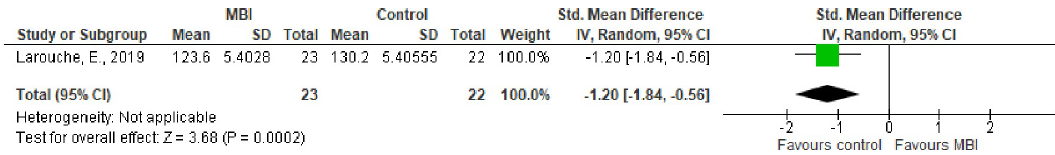
PLOS ONE | https://doi.org/10.1371/journal.pone.0255128 August 2,